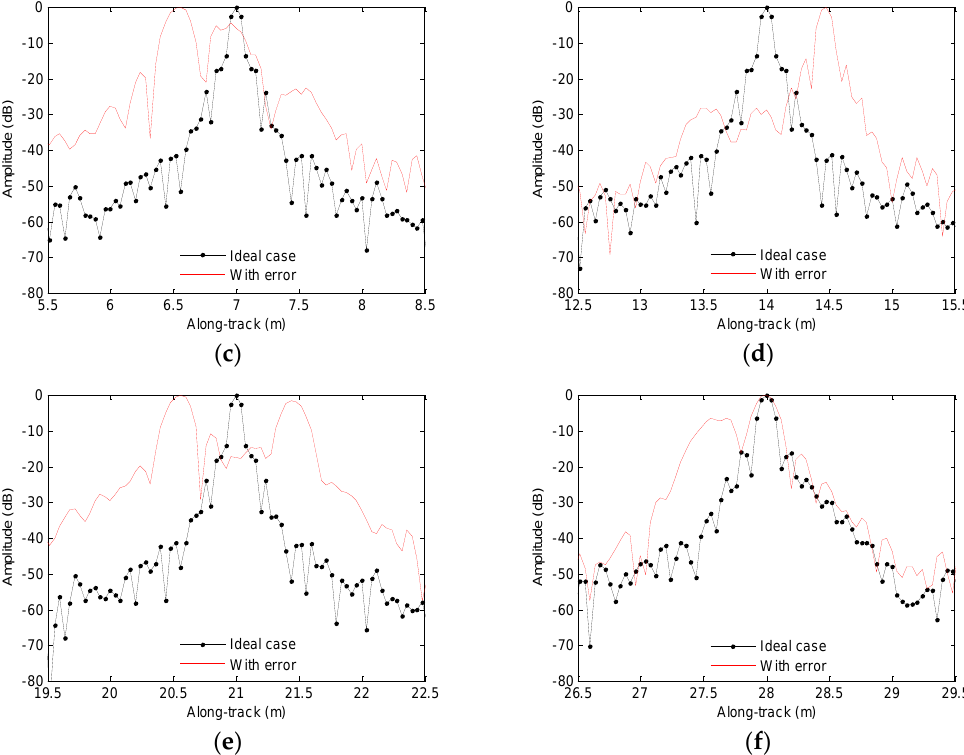
Figure 12. Processing results with the sawtooth heave: ( a ) imaging result; ( b ) slice of T1; ( c ) slice of T2; ( d ) slice of T3; ( e ) slice of T4; ( f ) slice of T5.